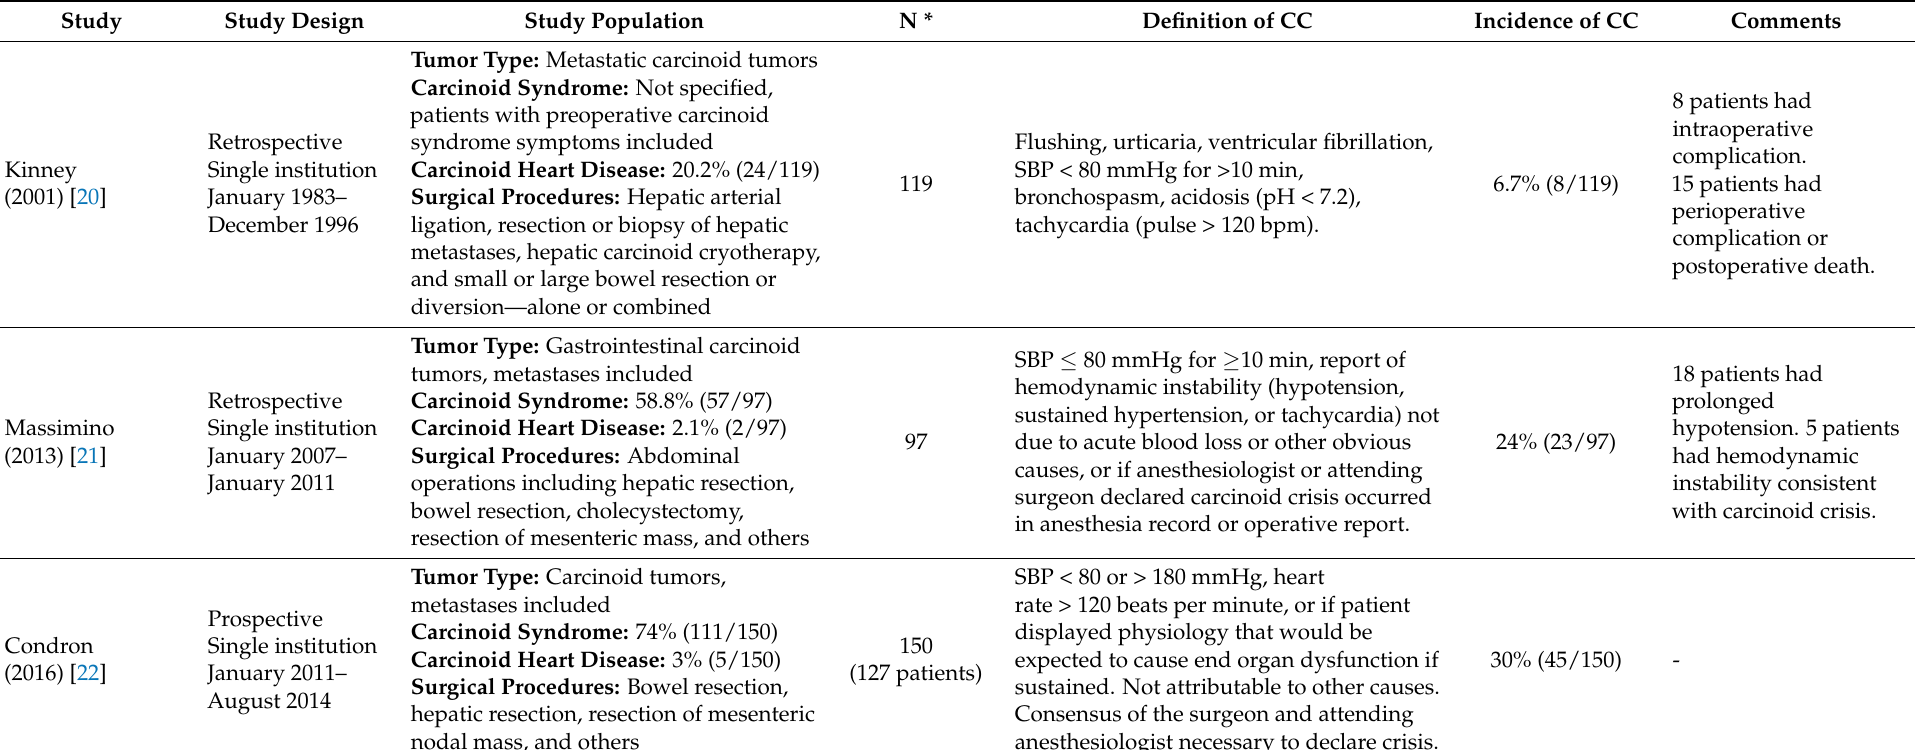
Table 1. Study characteristics, definition, and incidence of carcinoid crisis (CC) across included